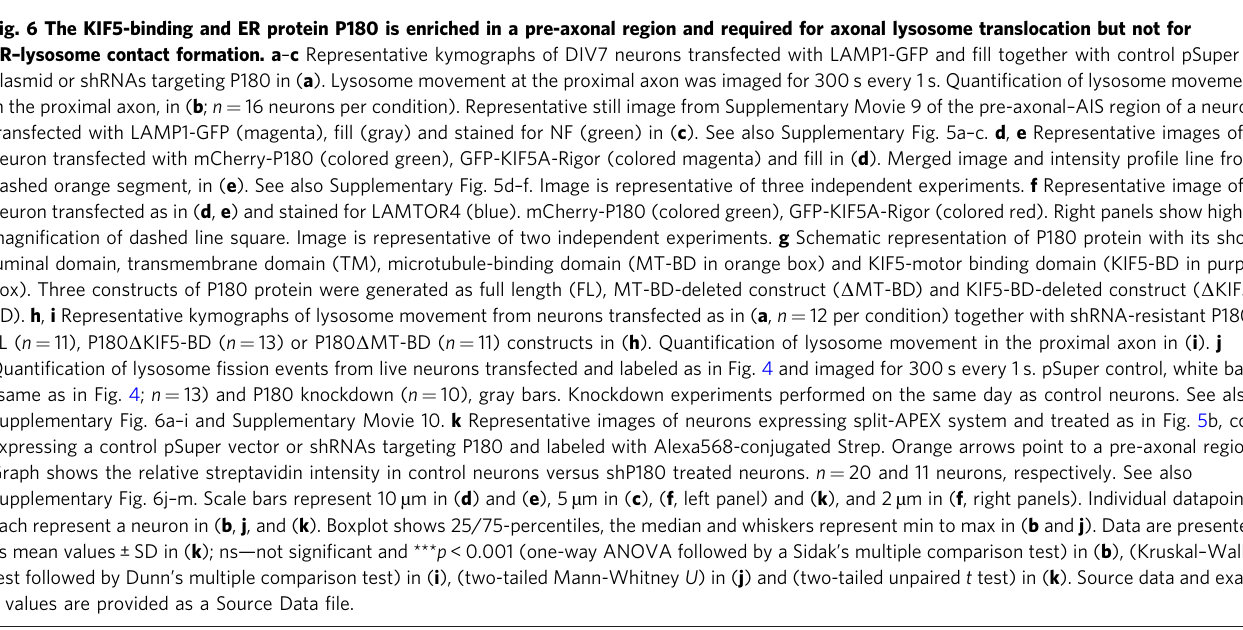
Fig. 6 The KIF5-binding and ER protein P180 is enriched in a pre-axonal region and required for axonal lysosome translocation but not for plasmid or shRNAs targeting P180 in ( a ). Lysosome movement at the proximal axon was imaged for 300 s every 1 s. Quanti fi cation of lysosome movement